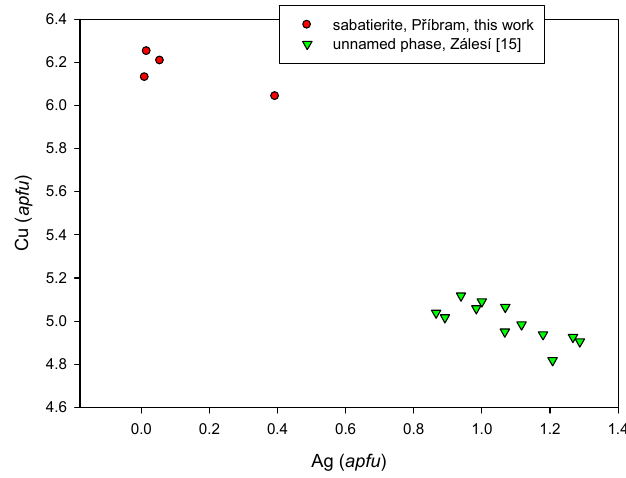
Figure 50. Ag vs. Cu ( apfu ) graph for sabatierite from P ř íbram and an unnamed Ag-Cu-Tl-Se phase from Zálesí.